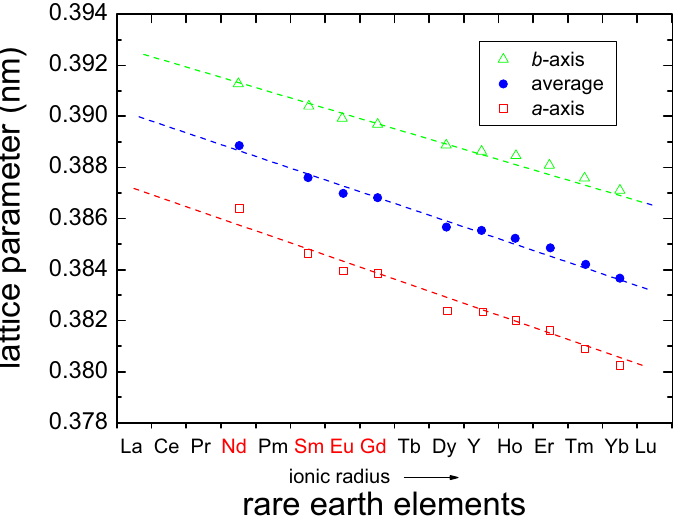
Figure 6. Cell parameters of various RE BCO compounds, taken from the ICDD database redrawn from Ref. [38]. The order of the elements on the horizontal axis follows the ionic radius of the RE -elements. The important light rare earth elements (LRE) are marked in red. Data are shown for the a -axes ( (cid:3) ) and the b -axes ( (cid:52) ), as well as their average size ( • ).